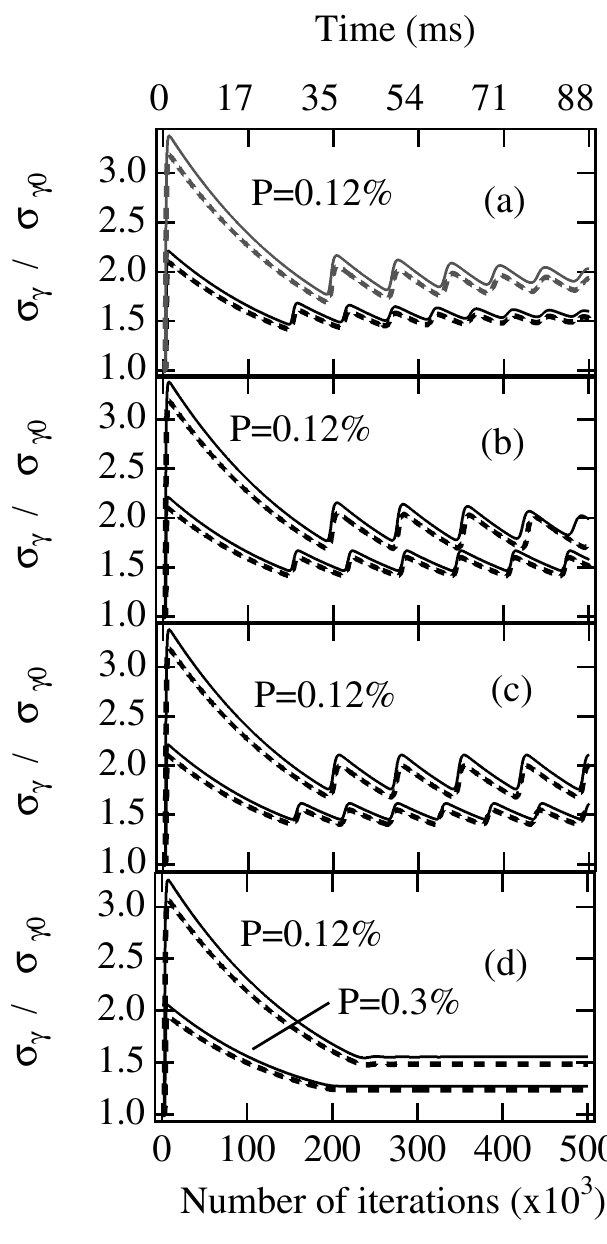
FIG. 9. Relative energy spread evolution with the LAS model for various detuning values: (a) (cid:12) (cid:6) 0 Hz , (b) (cid:12) (cid:6) 2 Hz , (c) (cid:12) (cid:6) 5 Hz (pulsed zone), (d) (cid:12) (cid:6) 40 Hz , and two values of the losses: P (cid:6) 0 : 12 and 0.3%. Continuous lines: achromatic point; dashed lines: chromatic point. An iteration corresponds to one revolution of the electron bunch in the storage ring. Simulations (cid:6) 1% , N (cid:7) N (cid:6) 87 : 5 . Those with etalas2v2, I (cid:6) 10 mA , g D 0 values correspond to experimental values. LAS takes into account the natural bunch lengthening FIG. 11. FEL power calculated with LAS in achromatic and (cid:6) (cid:7)c (cid:2) (cid:3) 0 , where (cid:2) is the experimental according to (cid:2) l 0 (cid:3) 0 w S chromatic cases compared with the experimental results. ( (cid:2) ) value measured at a current I. Simulations performed for Experiment and ( (cid:12) ) simulation in the achromatic case, ( (cid:3) ) different current values at P (cid:6) 0 : 12% lead to a heated experiment and ( 4 ) simulation in the chromatic case. The energy spread of 6 : 5 (cid:2) 10 (cid:3) 4 (achromatic case) and 6 : 2 (cid:2) parameters of the simulation are the same of the one used in 10 (cid:3) 4 (chromatic case) for I (cid:6) 20 mA , and of 1 : 2 (cid:2) 10 (cid:3) 3 Fig. 9, with P (cid:6) 0 : 12%